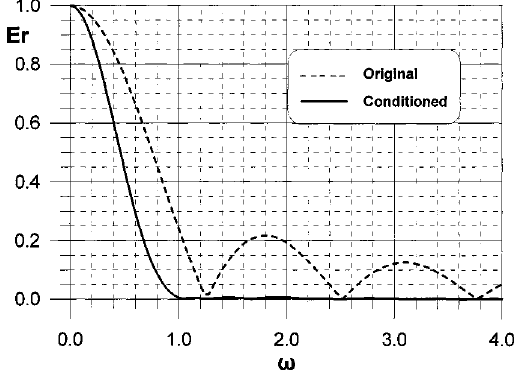
Fig. 12. Residual error function for variations of the eigenfrequency ! .